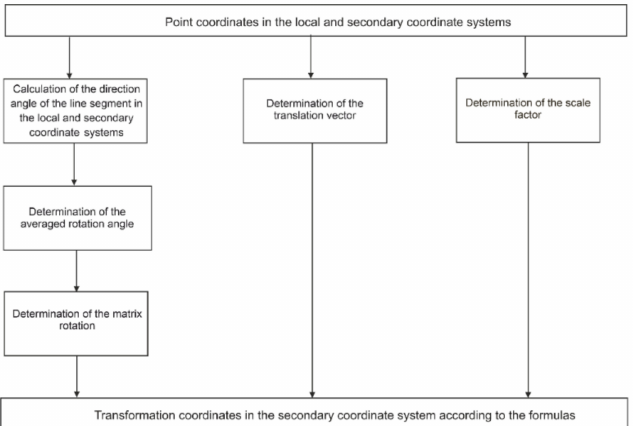
Figure 3. Flowchart showing steps of mathematical model for seven-parameter transformation (Bursa-Wolf transformation) according to the model of P.S. D ˛abrowski et al.